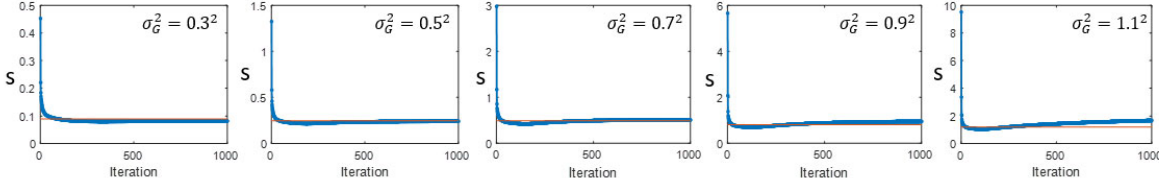
Figure 3. Comparison of estimated s by the joint-parameter-Bayes method (blue curve) and the true value of s (red curve). They agree well with each other, demonstrating the effectiveness of our proposed estimation